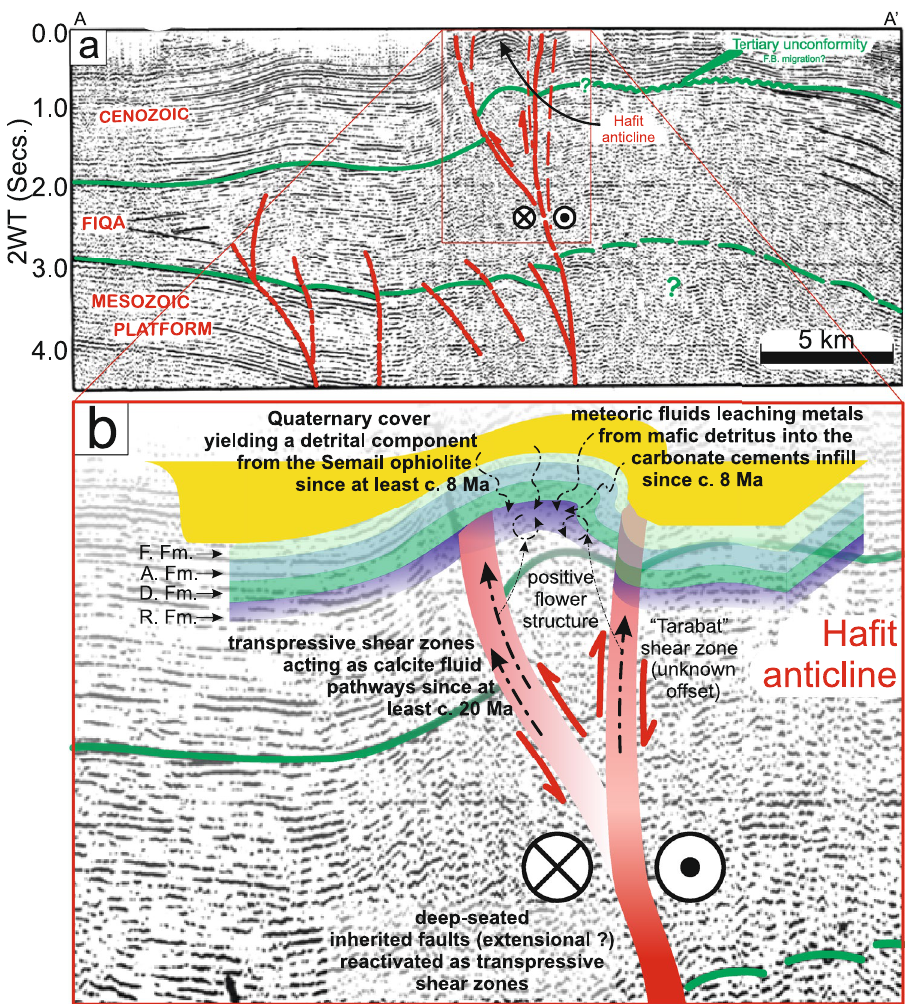
Figure 8. ( a ) SW-NE orientated seismic transect across the Jabal Hafeet structure (modified from 13 , position of the seismic line given on Fig. 1b). Solid and dashed red lines showing the position of transpressive shear zones (interpretation from 13 ). Green lines denote stratigraphic horizons between the underlying Mesozoic platform (Upper Cretaceous Fiqa Formation) and the overlying Cenozoic units (interpretation from 13 ). ( b ) schematic model of the Cenozoic deformation within the Jabal Hafeet anticline caused by shallow folding linking to deep high-angle reverse faults cutting from the Cretaceous into the Cenozoic units. F. Fm. Fars Formation, A. Fm. Asmari Formation, D. Fm. Dammam Formation, R. Fm . Rus Formation. Shaded red planes showing the possible location of the transpressive faults that act as pathways for the carbonate-rich fluids (dashed black arrows) that infill shear planes within the Rus Formation. Red arrows show the interpreted kinematics of the transpressive